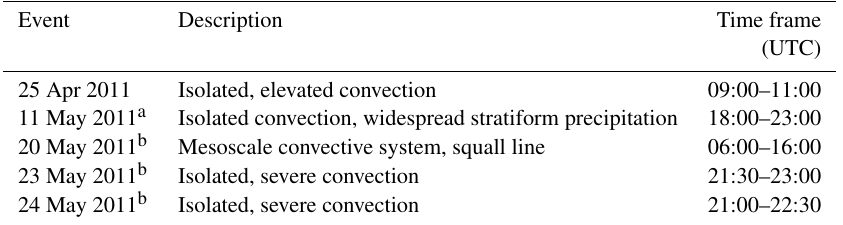
Table 1. Prominent convective events during MC3E, including a brief description and approximate time frame each event was sampled by